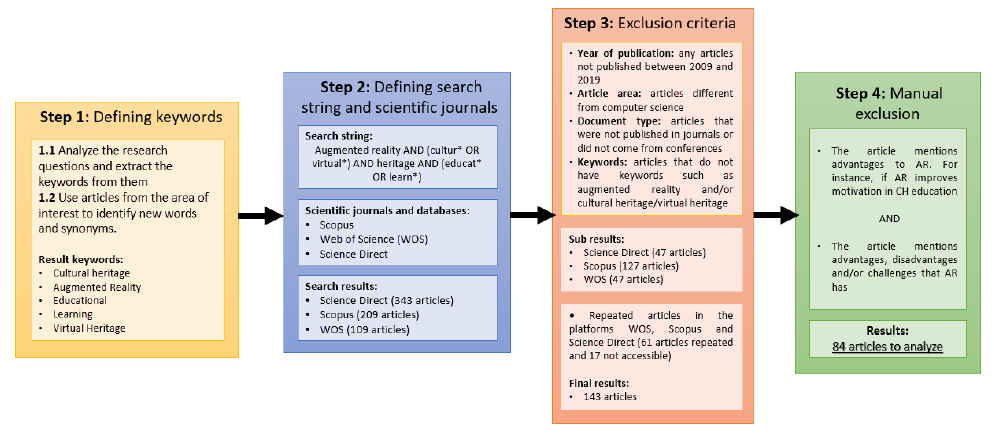
Figure 2. Steps for article evaluation